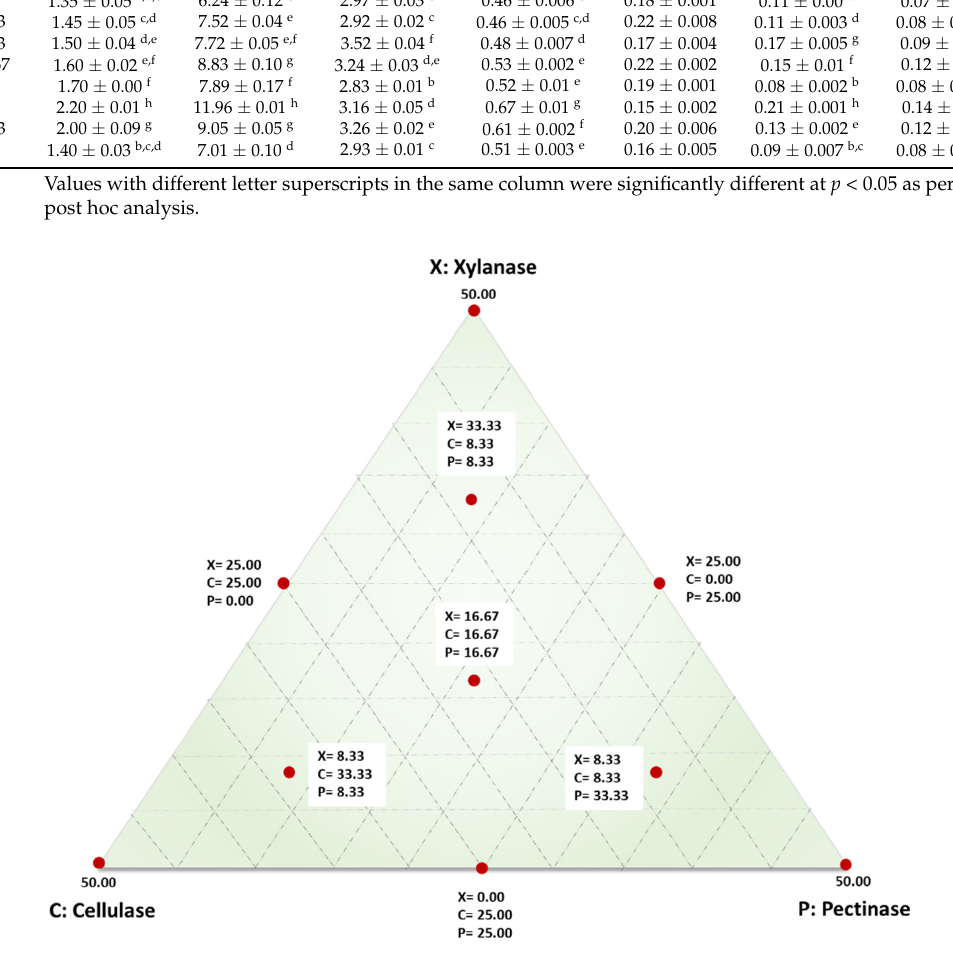
Figure 1. Points augmented simplex lattice mixture design for enzyme cocktail formulations comprising of xylanase (X), cellulase (C), and pectinase (P) with the mixture sum at the vertices representing the overall cocktail concentration of 50 mg/100 g dry matter.